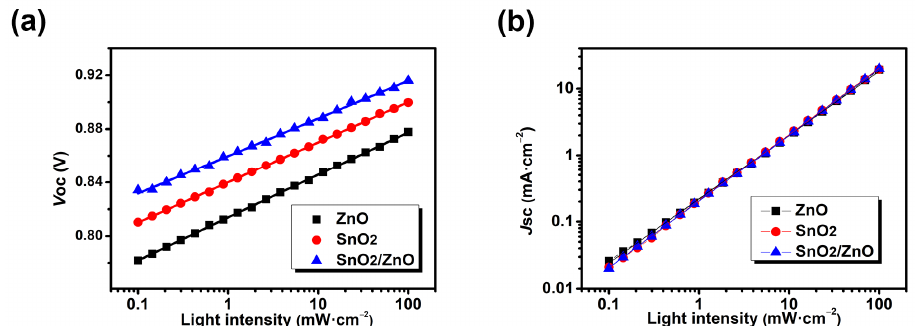
Figure 4. The light intensity dependence of ( a ) V OC and ( b ) J SC of the device with different cathode buffer layers.